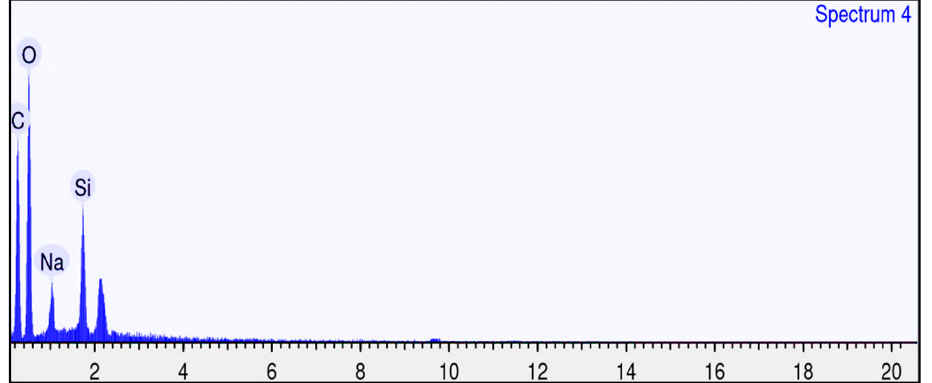
Figure 4. ( a ) N 2 adsorption/desorption isotherm and ( b ) pore size distribution curve of 2:1 inulin–TEOS hybrid adsorbent.